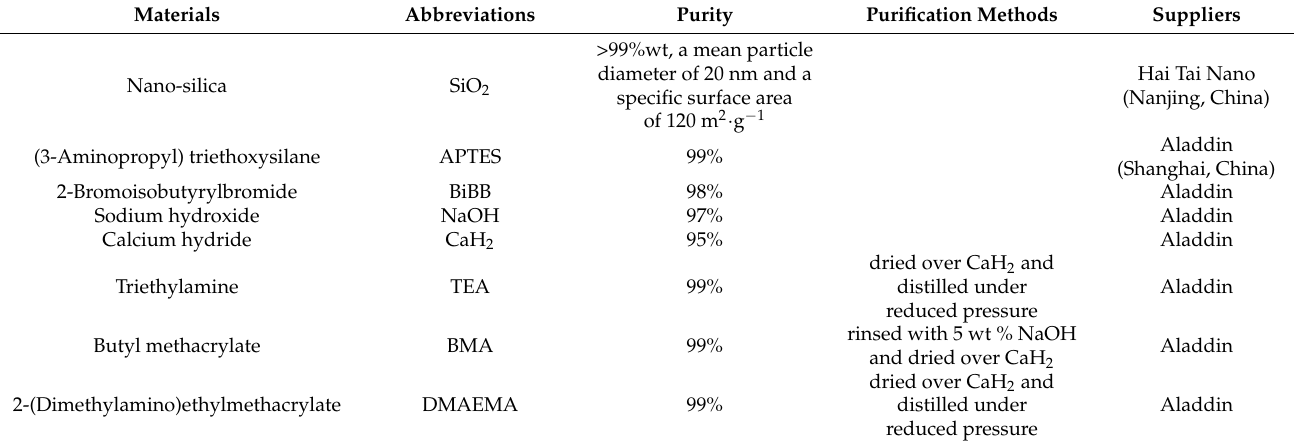
Table 1. Materials and the corresponding purification